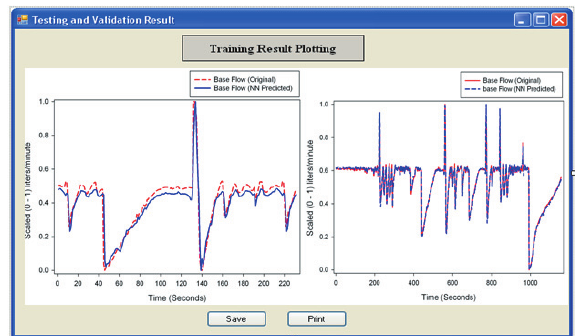
Figure 12: Testing and validation result